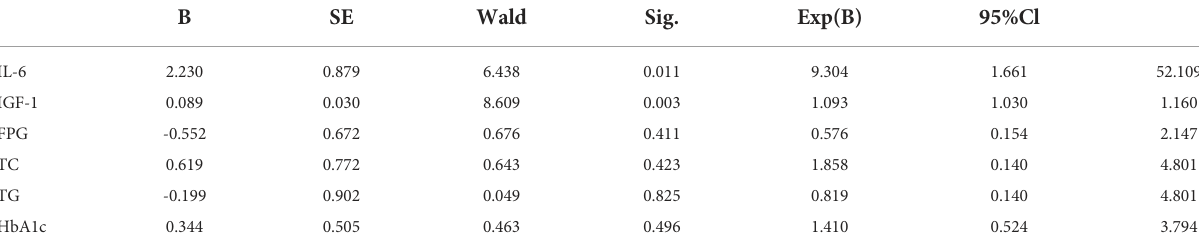
TABLE 2 Logistic regression analysis of clinical biological indicators and the progression of DKD. B SE Wald